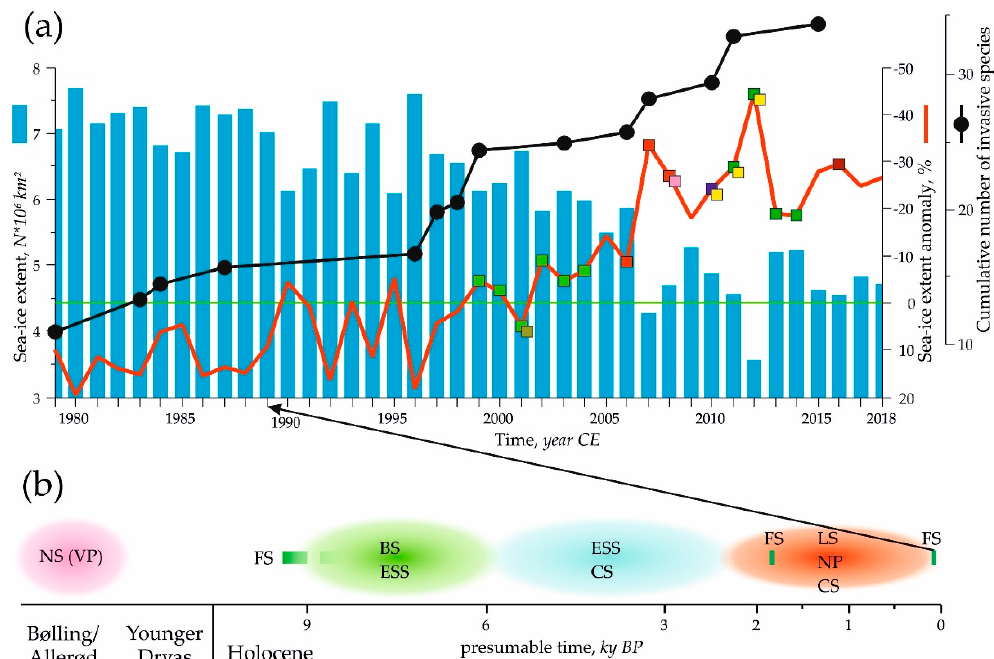
Figure 4. Records of N. seminae in the modern Arctic and North Atlantic and the Holocene sediments of the Arctic and Nordic Seas (see references in the Figure 3 caption). ( a ) N. seminae in the modern Arctic and North Atlantic: black ‐ framed green and blue squares mark observations of N. seminae in the plankton, black-framed yellow squares mark observations of N. seminae in sediment trap NAP, black-framed red, brown, and rose squares mark observations of N. seminae in surface sediments. The Arctic sea-ice extent (vertical blue bars) and its anomalies (red line) are from [80]. Cumulative number of the invasive species (black dots and line) in the marine Arctic is from [81]. ( b ) N. seminae in the latest Pleistocene and Holocene sediments: green bars, green, blue, red, and pink ovals mark observations of N. seminae in the different areas within the different time intervals. NS(VP) is Norwegian Sea (Vøring Plateau), FS is Fram Strait, BS is Barents Sea, LS is Laptev Sea, ESS is East Siberian Sea, CS is Chukchi Sea, NP is North Pole.